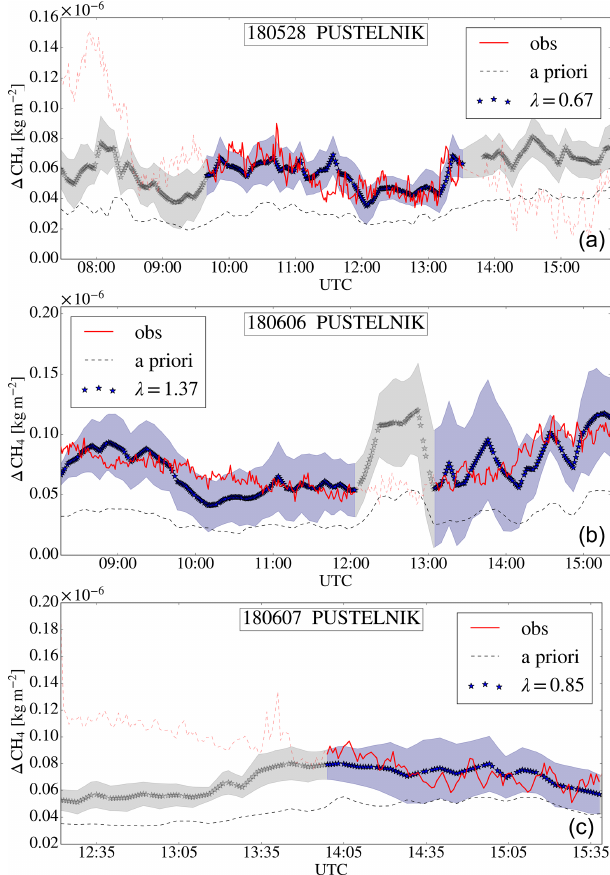
Figure 8. (cid:49) XCH 4 for 28 May (a) , 6 June (b) , and 7 June (c) 2018 measured (red solid and dotted line) and simulated based on the a priori emissions (grey dashed) and on optimized emissions (dark grey and blue) at the station Pustelnik (S). The grey and blue shad- ings indicate the uncertainties due to measurement errors and atmo- spheric variability.